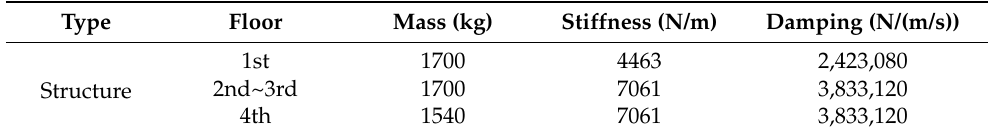
Table 4. Simplified parameters of the